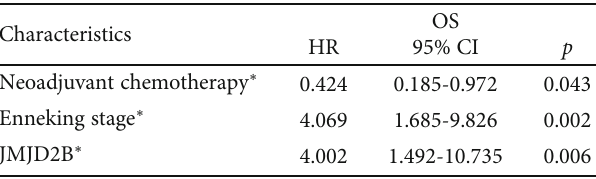
Table 4: Multivariate Cox proportional regression analysis for the association of clinicopathological factors with overall survival of OS